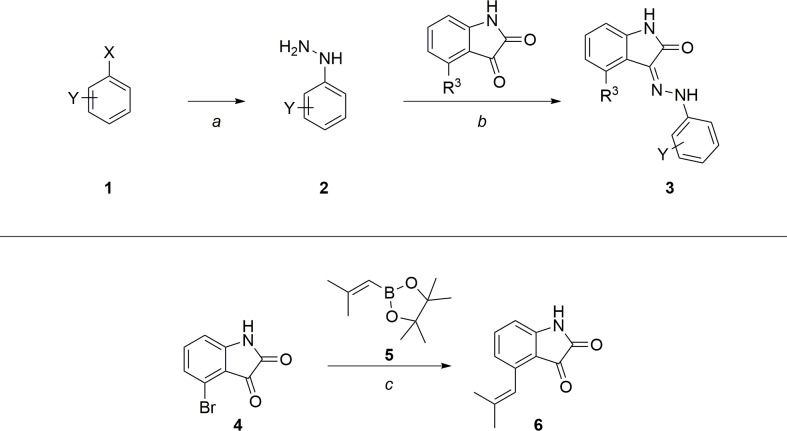
General scheme for synthesis of sulfonamide replacements and construction of substituted isatin core.Reagents and reaction conditions: a) Aryl halide, hydrazine monohydrate; 120°C, 12 h (52–86%). b) Isatin, methanol; RT, 12 h (10–100%). c) 4-Bromoisatin, boronic acid pinacol ester, K2CO3, Pd(PPh3)4; 100°C, 12 h (66%).